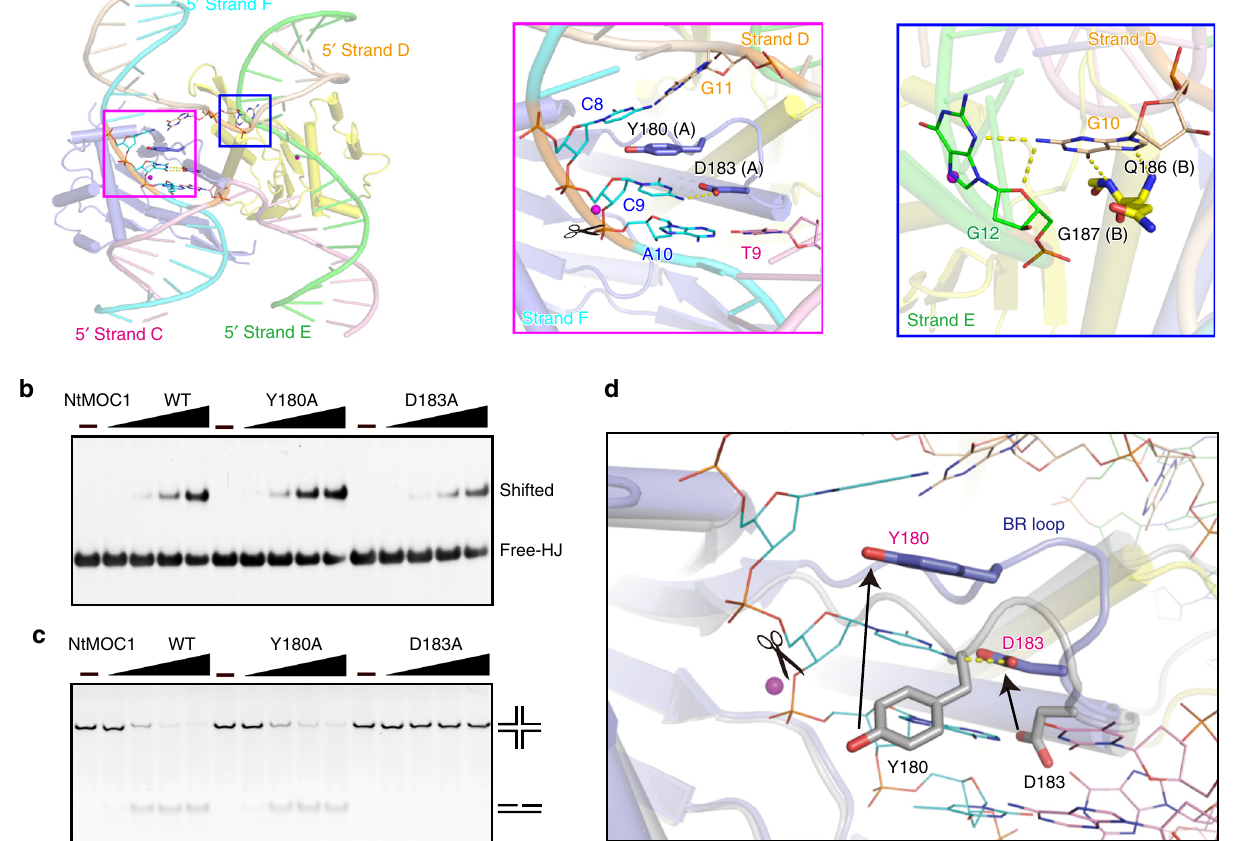
Fig. 5 Molecular basis of cytosine-dependent HJ resolution by NtMOC1. a The C – G base pairs at the crossover are disrupted by NtMOC1. Left panel: Overall view of the disrupted C – G base pairs in the complex. Middle panel: The disrupted cytosine (C9) interacts with D183 via a hydrogen bond. Right panel: The fl ipped-out guanine is stabilized by residues and nucleotides. b, c HJ binding ( b ) and cleavage ( c ) activity examined for NtMOC1 with alanine substitutions of Y180 and D183. For the HJ binding and cleavage assay, X2 (CCGG) was used as HJ substrate. The fi nal concentration of HJ in each lane was 250nM. Five gradients with increasing concentrations (0, 125, 250, 500, and 1000 nM) were applied for each protein sample. The reactions were resolved by native PAGE and visualized by GelRed staining. Source data are provided as a Source Data fi le. d The BR loop undergoes a striking conformational change. Apo NtMOC1 is shown in the gray cartoon illustration. The protomers of HJ-bound MOC1 are shown in slate and yellow cartoons, respectively. DNA strands are shown with lines. The purple circle indicates the magnesium ion in the complex structure. The yellow dashed line indicates the hydrogen bond formed between D183 and cytosine. Arrows indicate the displacement of Y180 and D183. Residues in the apo and complex structures are labeled in black and magenta, respectively. The scissors indicate the cleavage